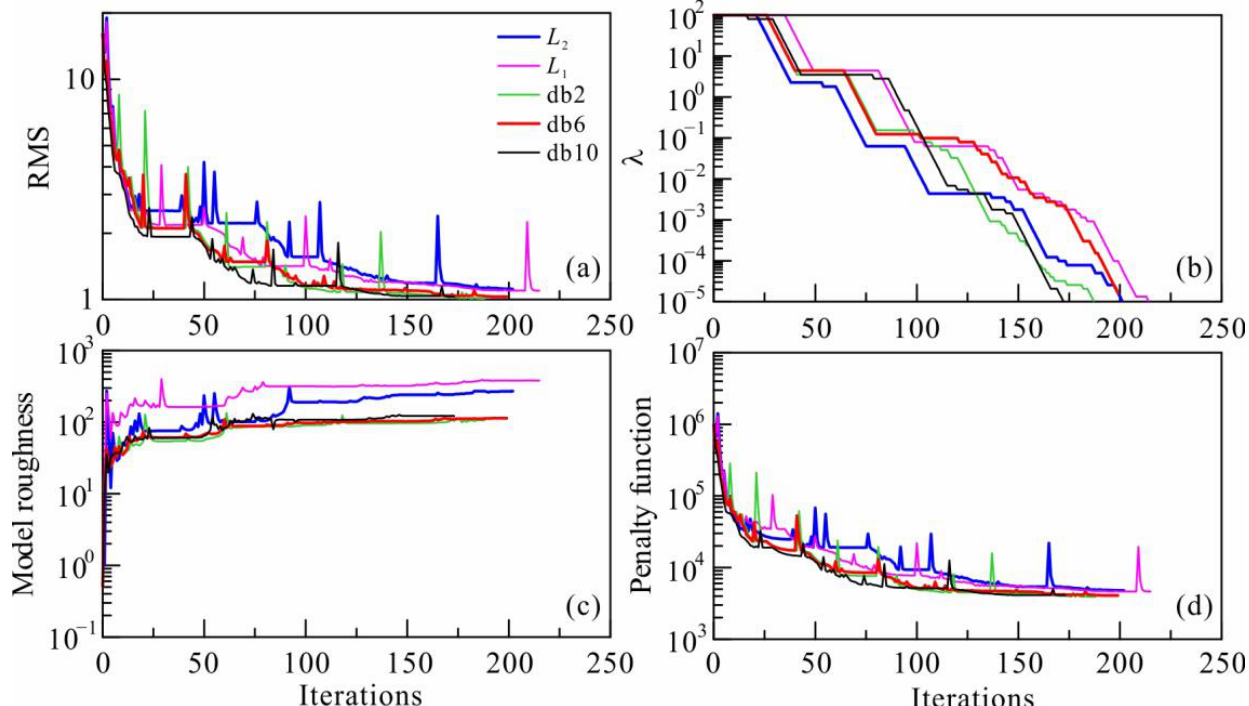
Figure 6. Plots of variations in inversion parameters with iterations. ( a ) Root mean squares (RMS) of data misfit, ( b ) regularization parameter λ, ( c ) model roughness, and ( d ) penalty function.